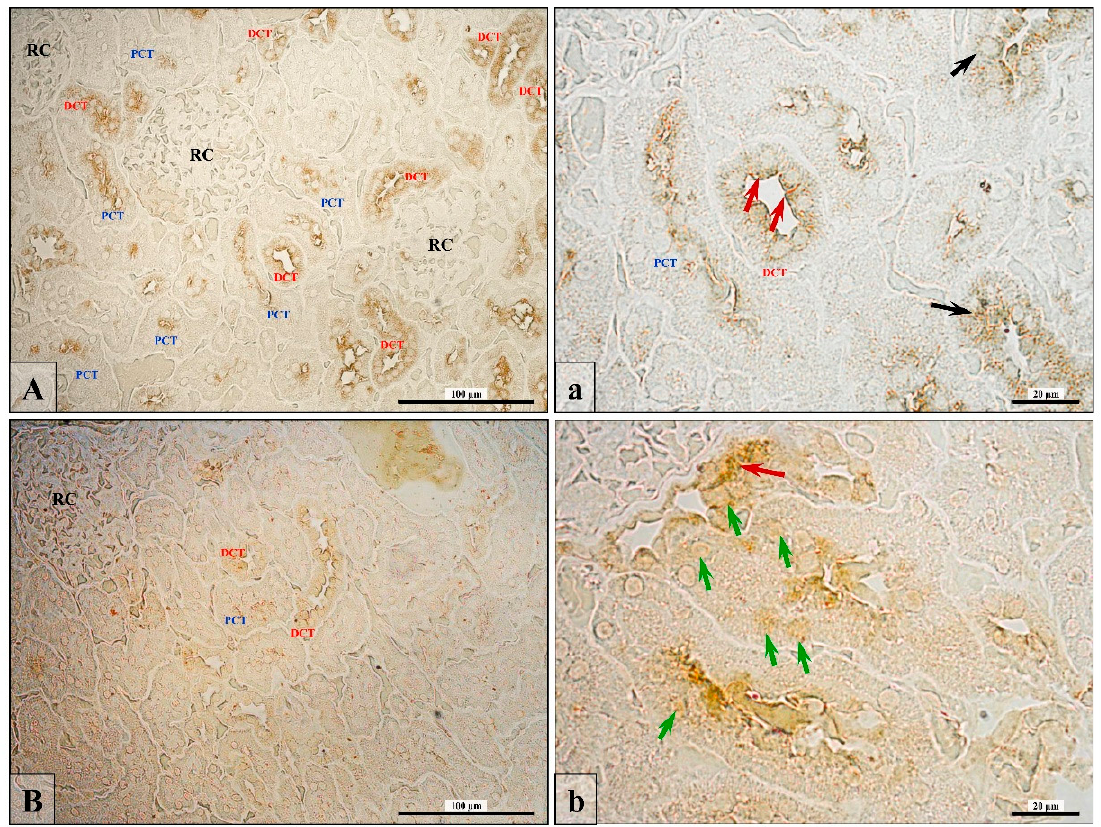
Figure 2. The representative microphotographs showing the expression of the androgen receptor (AR) in kidney of control ( A , a ) and finasteride-treated rats ( B , b ). In the control group, AR was most frequently expressed in DCT than PCT ( A ) and mainly in the cells’ cytoplasm around the nucleus (a; black arrows) or in the apical area of cells (a; red arrows). In rats with DHT deficiency, AR expression became very low ( B ) and mainly translocated from the apical region (b; red arrow) into the cell nucleus (b; green arrows). Scale bar from objective magnification ×40 is 100 µm ( A, B ), from x100 is 20 µm ( a, b ).